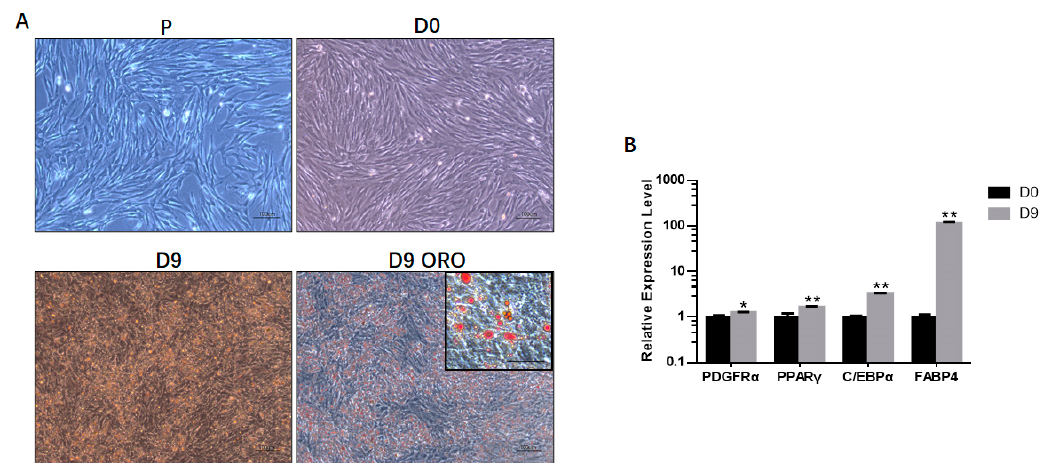
Figure 1. Adipogenic differentiation of bovine fetal skeletal muscle-derived PDGFR α⁺ cells. ( A ) Shown are proliferating PDGFR α + cells (P) on Day 0 (D0) and Day 9 (D9) following adipogenic differentiation. Differentiated cells on Day 9 were stained with Oil Red O (D9 ORO). Scale bar = 100 µm, inset scale bar = 50 µm. ( B ) Relative gene expression of adipocyte-specific genes on Day 0 (D0) and Day 9 (D9). All the measurements shown are the means ± SEM of four biological replicates from independent cell experiments. * p < 0.05; ** p < 0.01.